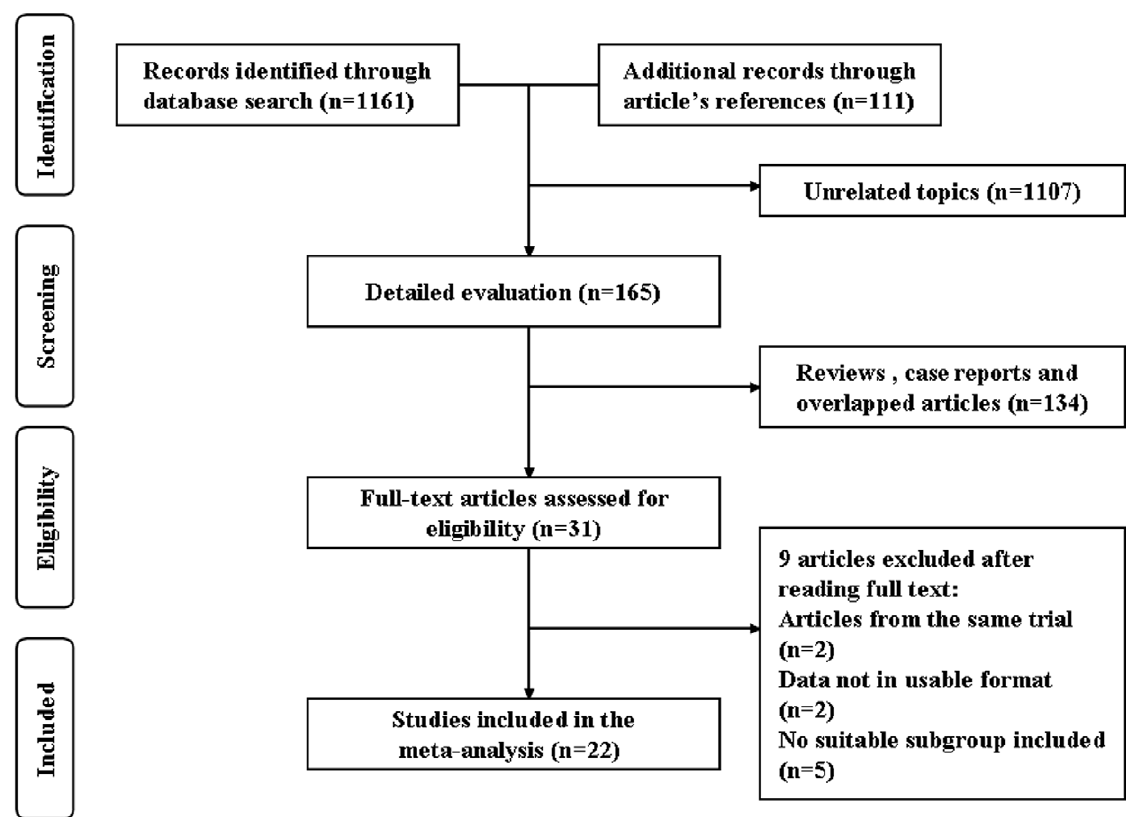
Figure 1. Search strategy flow diagram about with or without the use ICG in macular hole surgery.